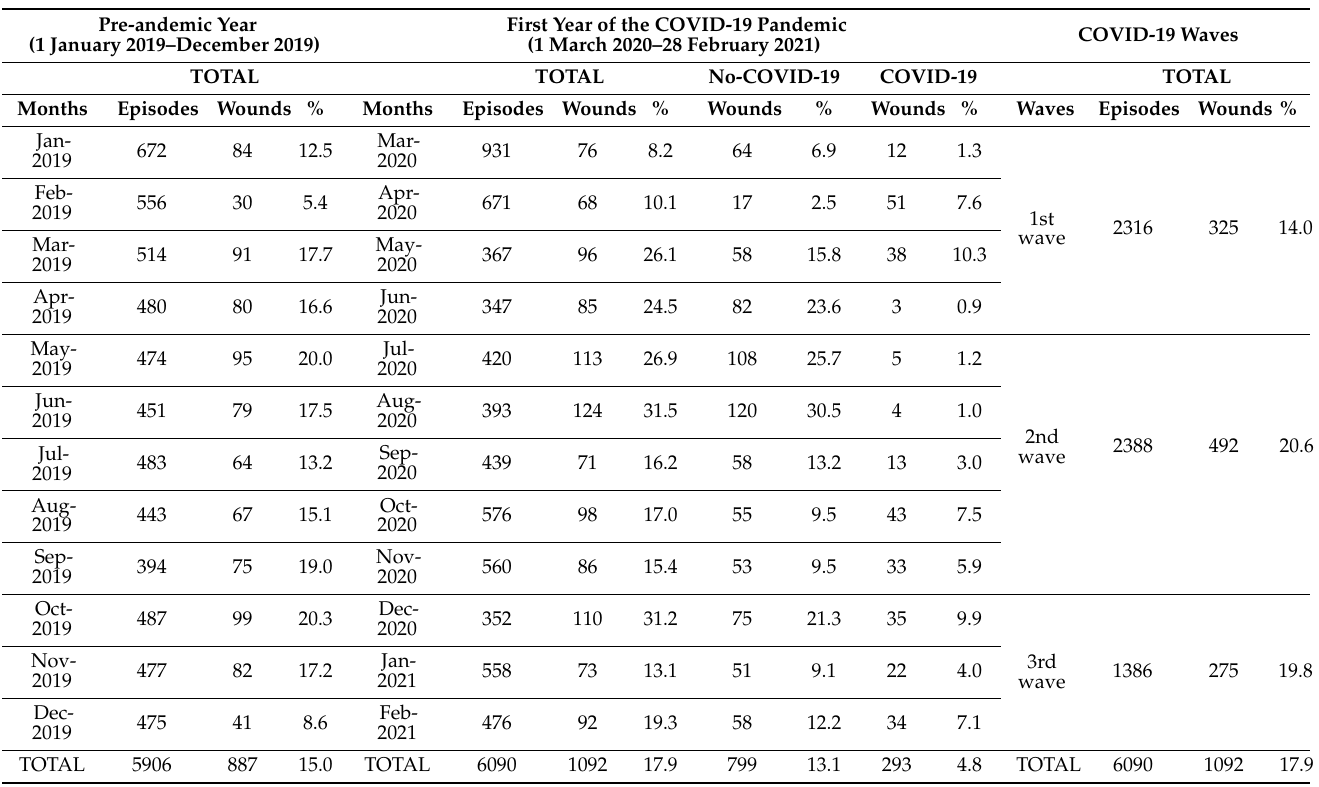
Table 1. Episode registry in the C.A.U.S.A. Internal Medicine Units.